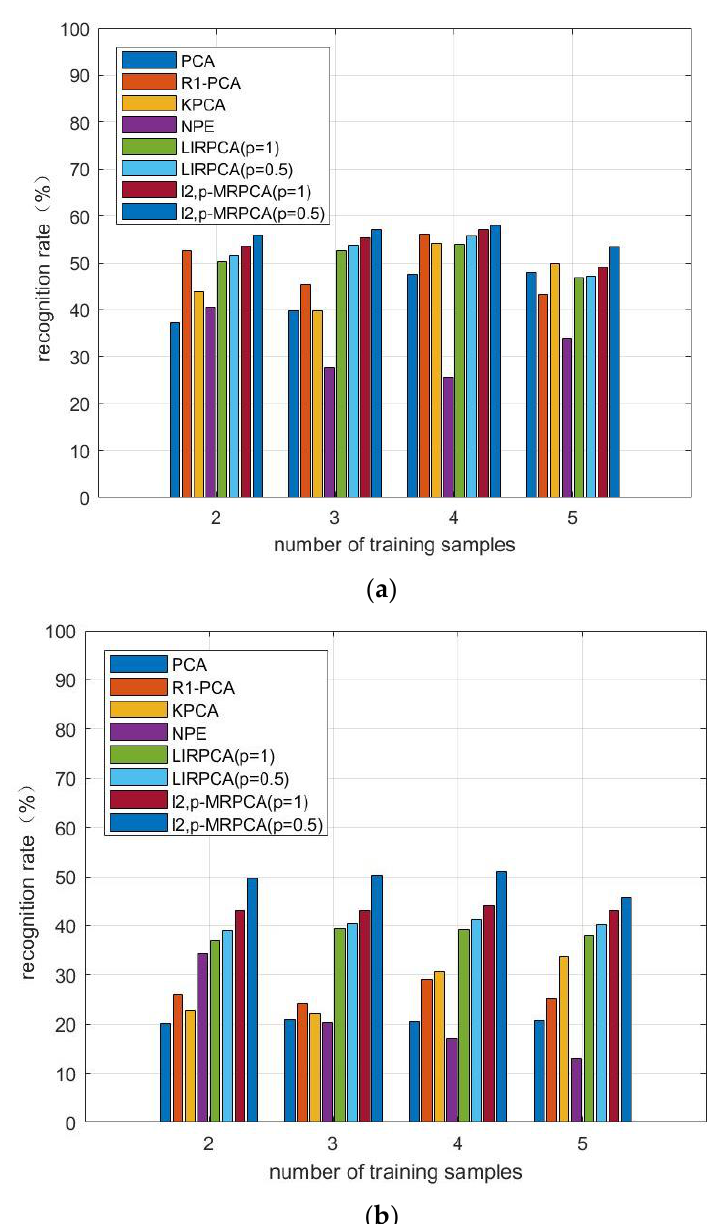
Figure 4. Recognition rate of PCA, 𝑅 1 -PCA, KPCA, NPE, LIRPCA( 𝑝 = 0.5 ), LIRPCA( 𝑝 = 1 ), 𝑙 2,𝑝 -MRPCA ( 𝑝 = 0.5 ), 𝑙 2,𝑝 -MRPCA ( 𝑝 = 1 ) on FERET database ( a ) original image ( b ) block size = 5 × 5.